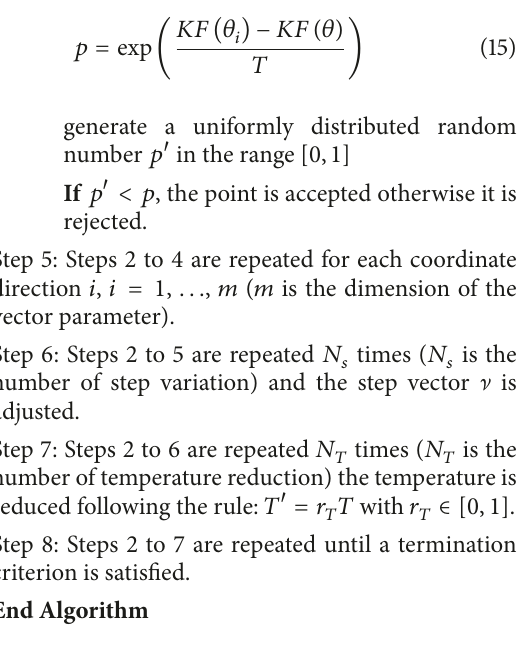
Table 1: Mean and MSE of estimated parameters for Example 1; 𝑛 = 100 .